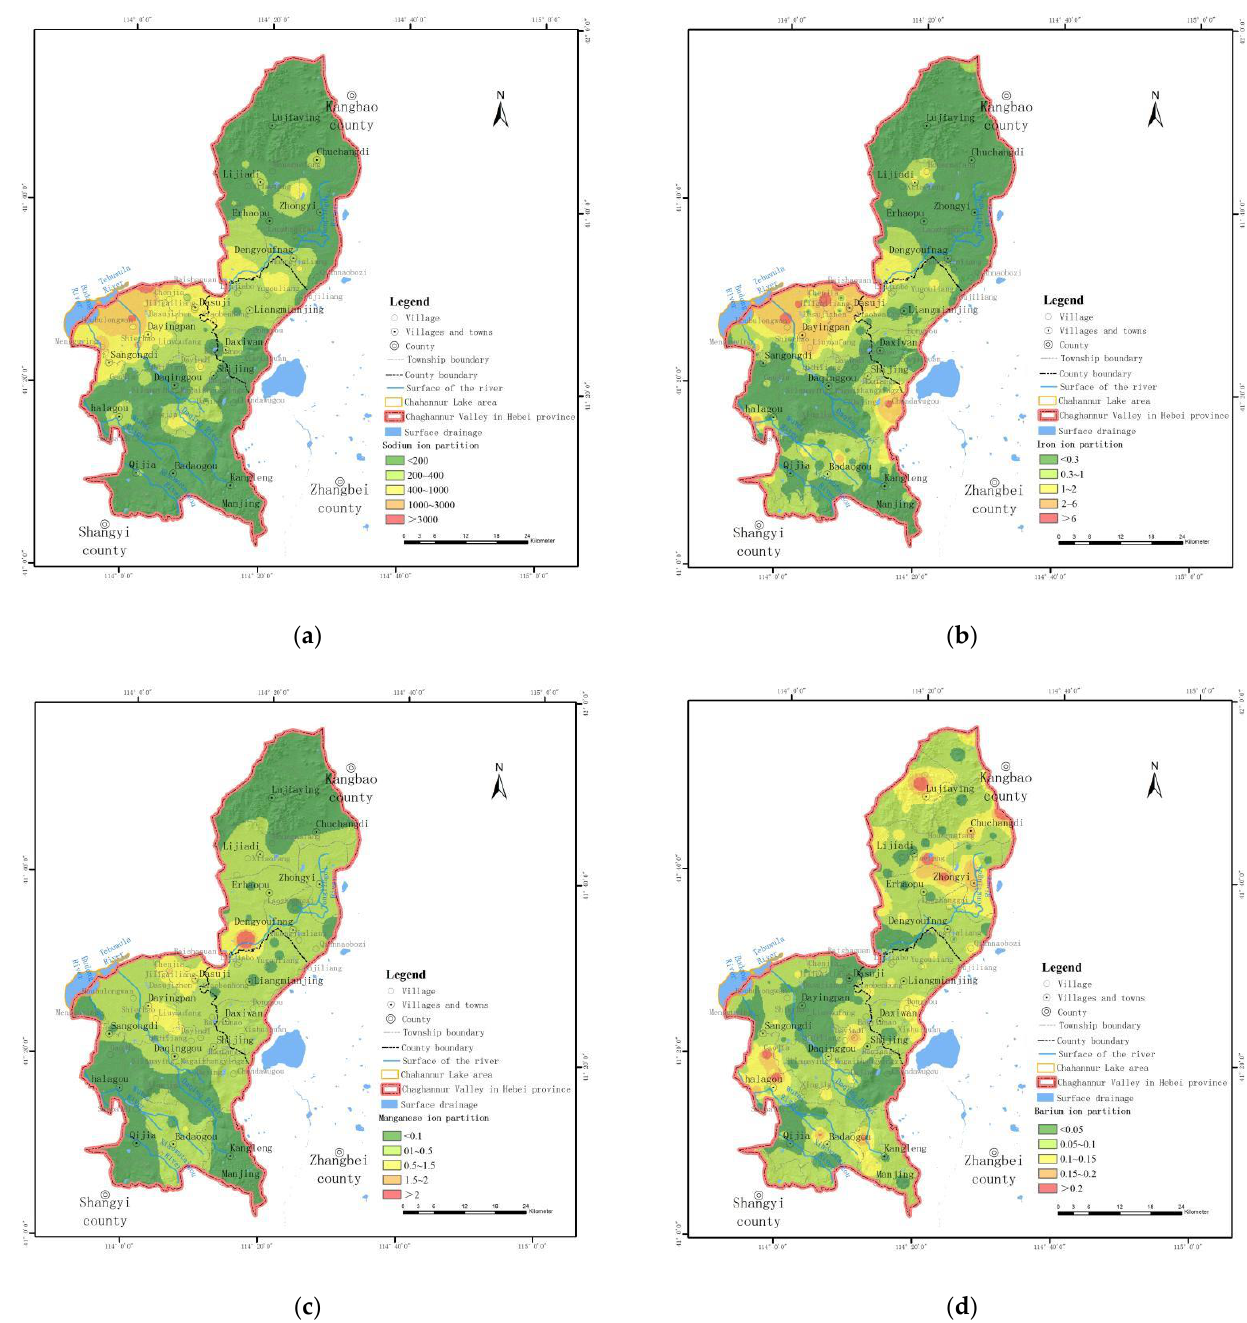
Figure 8. Spatial distributions of ( a ) Na + , ( b ) Fe, ( c ) Mn 2+ and ( d ) Ba 2+ in Chahannur